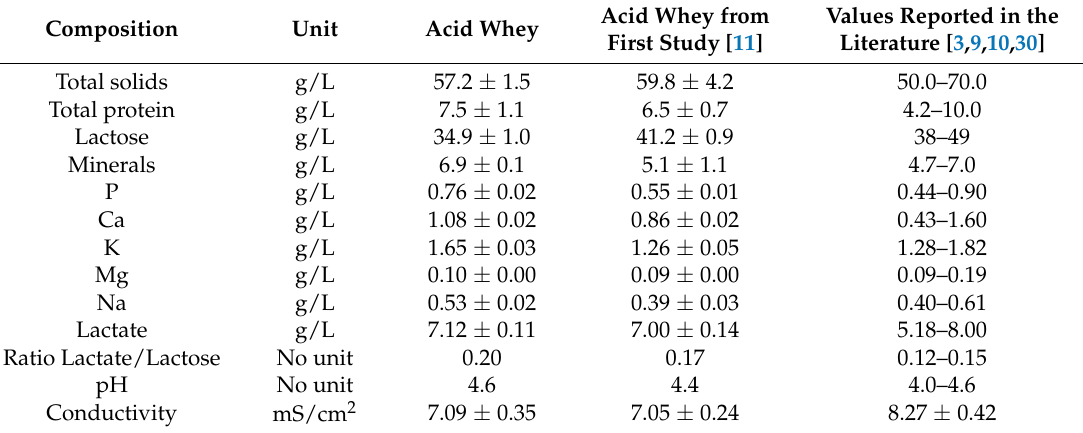
Table 2. Raw acid whey composition and physicochemical characteristics.